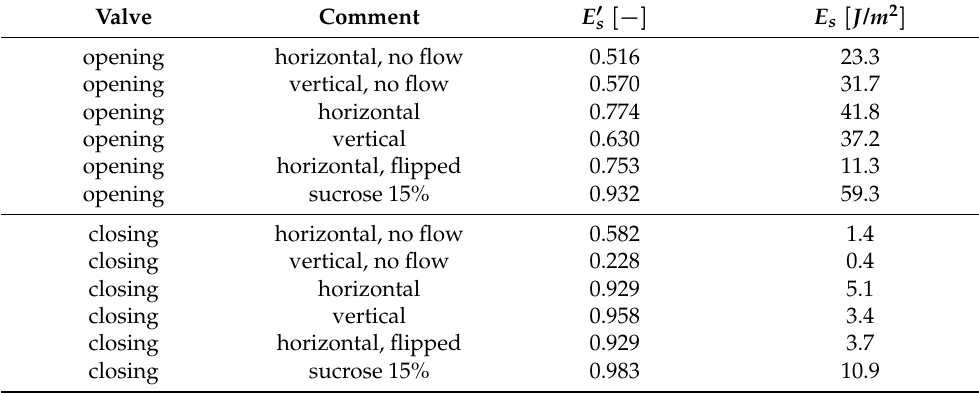
Figure 4. Case: valve opening, experimental results for horizontal set-up. In the ( top left ) panel pressure signal captured before and after the filter is shown. Specific intake intensity versus time is shown in ( top right ). ( Bottom row ): wave intensity and wave amplitude spectra. Table 2. Dimensional ( E s ) and non-dimensional ( E (cid:48) s ) specific energy intake for all experimental cases with laboratory scale filters. The dimensional specific energy intake was calculated using time resolution of 20 µ s and 100 µ s and moving window size 512 for experimental